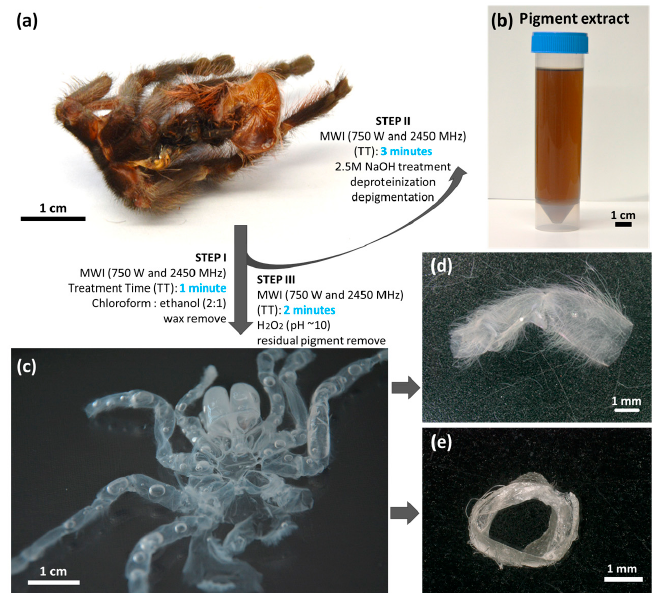
Figure 3. Schematic view of the microwave-assisted method (MWI) for both chitin and pigment isolation from ( a ) the molt cuticle of the spider C. versicolor . ( b ) Brownish colored pigment extract was obtained after alkali-based treatment. ( c ) The pigment-free, translucent molt represents a source of prefabricated tubular chitin that resembles the shape, ( d , e ) size, and morphology of the spider’s walking legs. See also Figure 4.